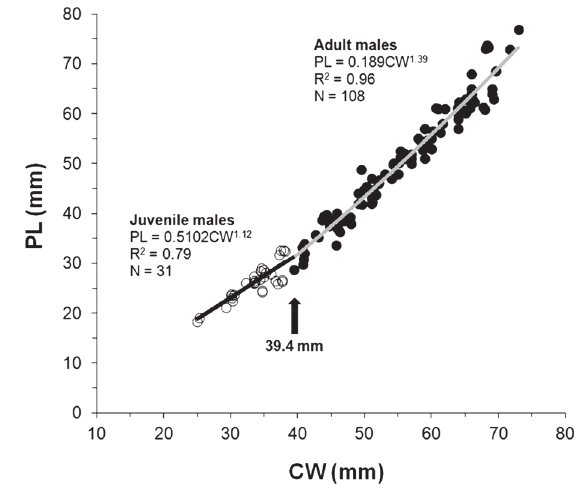
Figure 4 . Ucides cordatus (Linnaeus, 1763). Scatter plot of the CLxCW relationship, based on male crabs captured monthly in the mangroves of the Joanes River, Lauro de Freitas Municipality (BA, Brazil) between September 2011 and August 2012. The arrow indicates the size at morphological maturity, PL is the propodus of the major cheliped, CW is the carapace width, N is the number of individuals, and R 2 is the coefficient of determination.